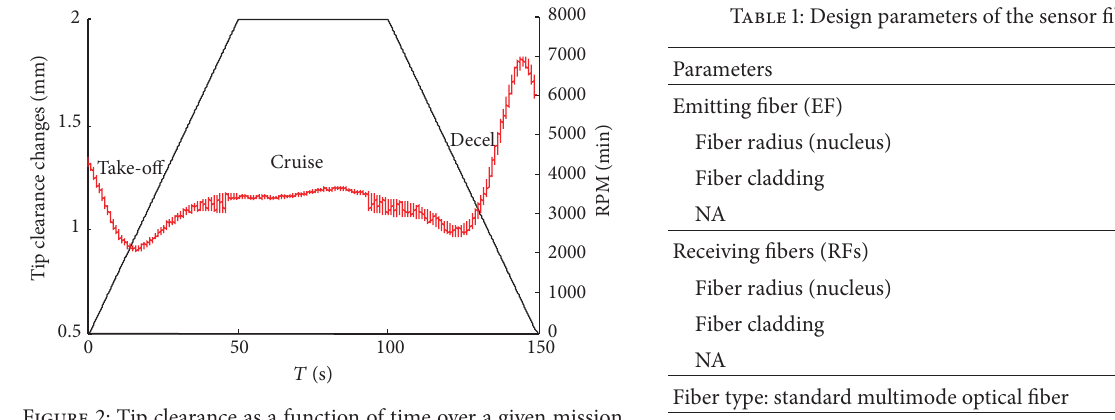
Figure 2: Tip clearance as a function of time over a given mission profile.